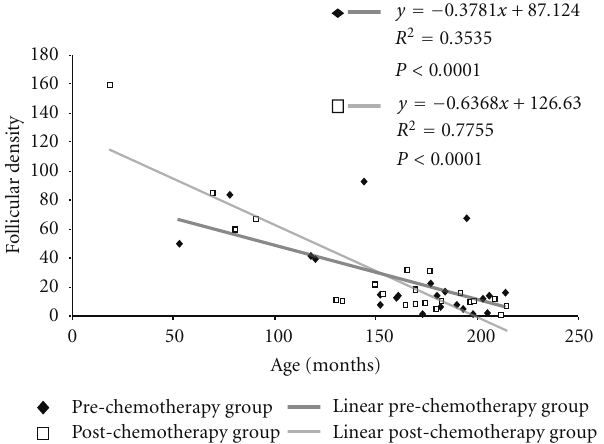
Figure 1: Correlation between age and follicular density in pre- chemotherapy and post-chemotherapy groups.